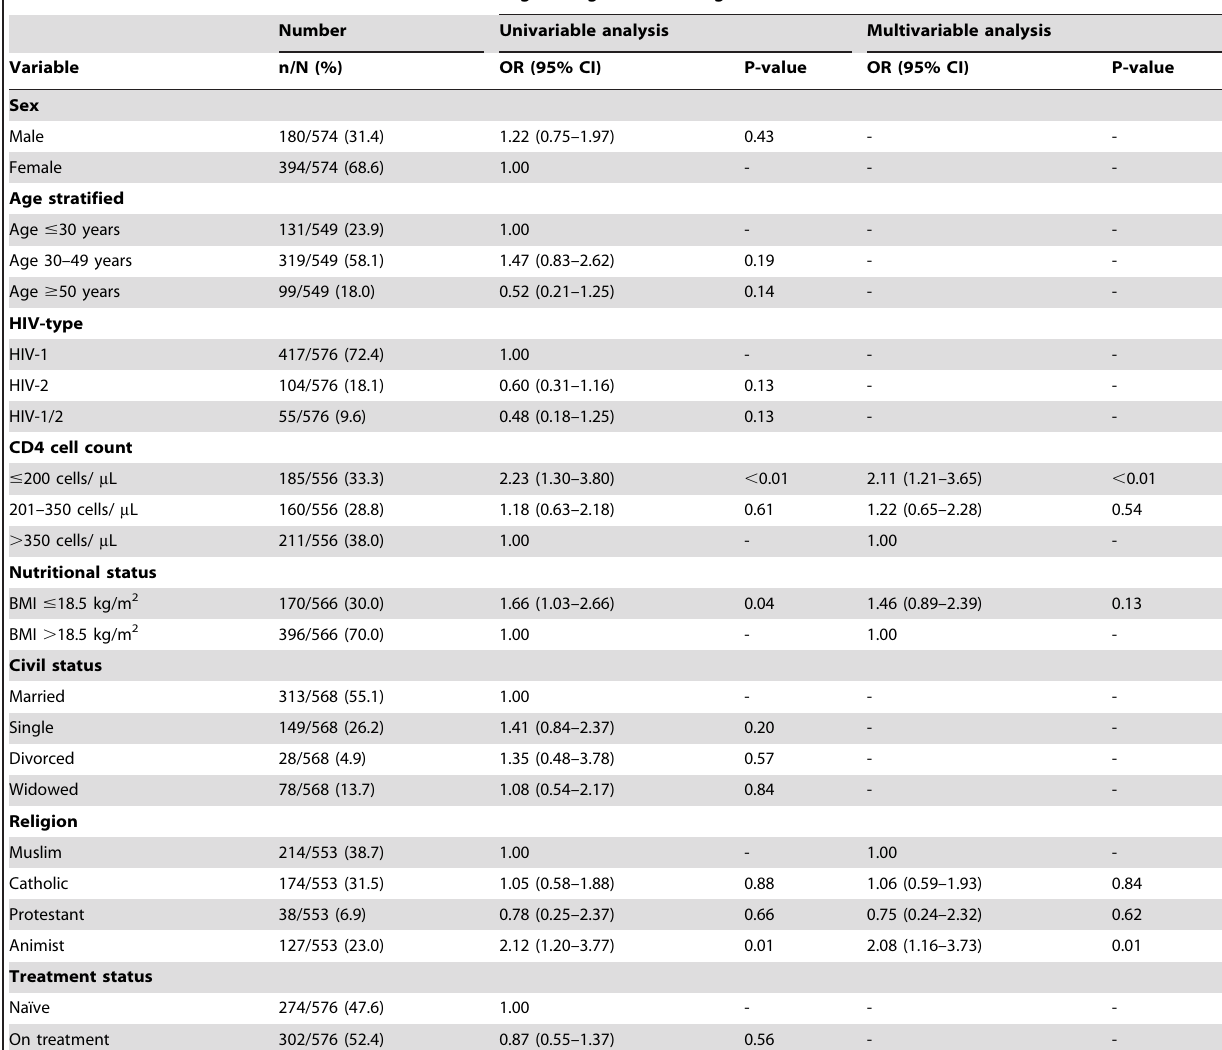
Logistic regression, HBsAg Odds Ratio